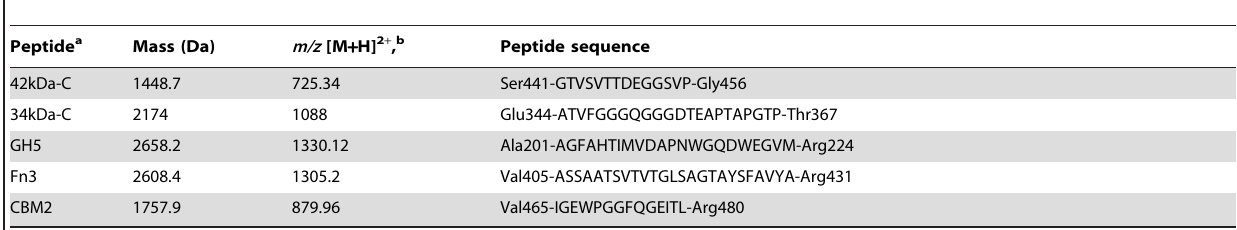
Table 1. Peptide sequences identified by mass